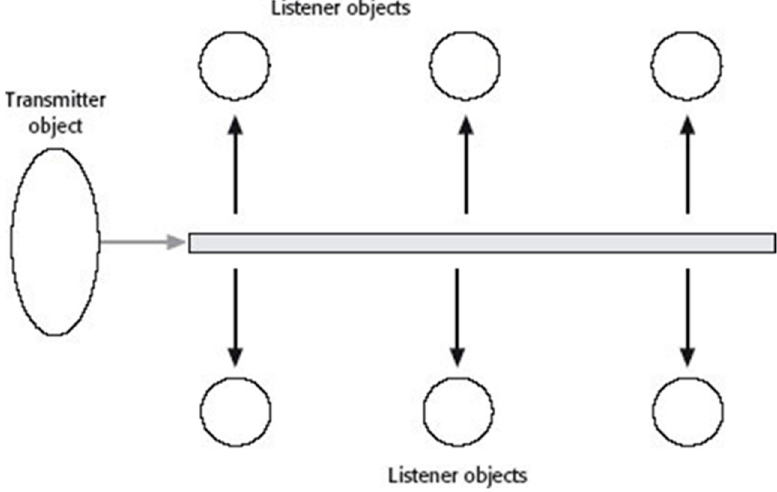
Figure 6. Multicast architecture [104].